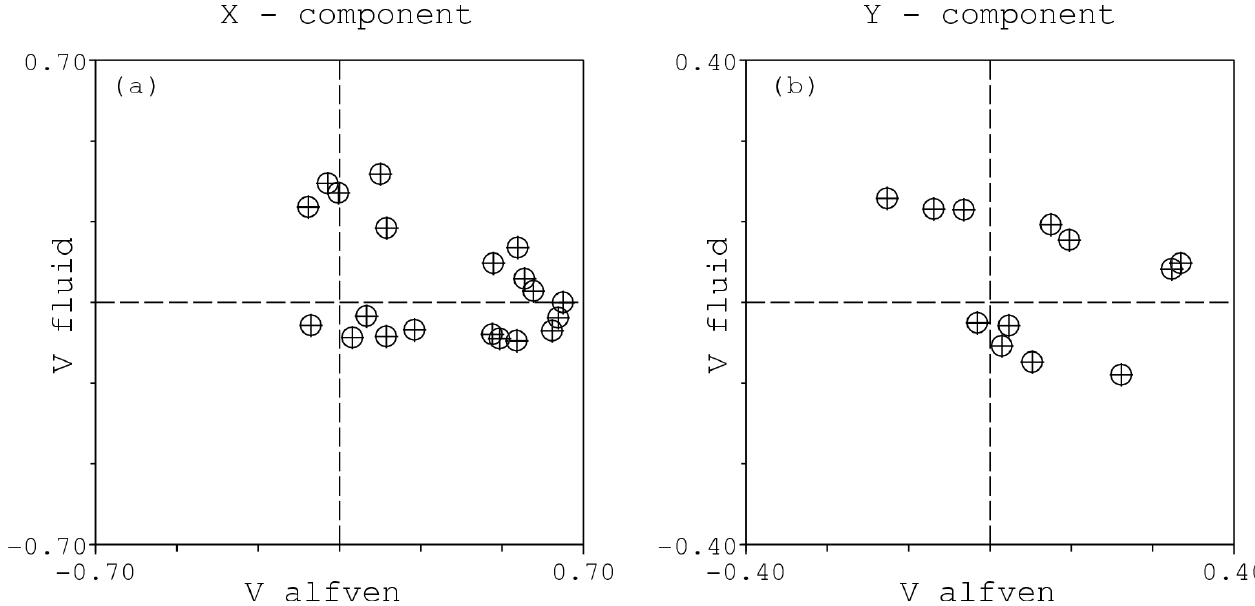
Fig. 8. (Left) normal and (right) tangential fluid velocity as a function of Alfv´en speed.